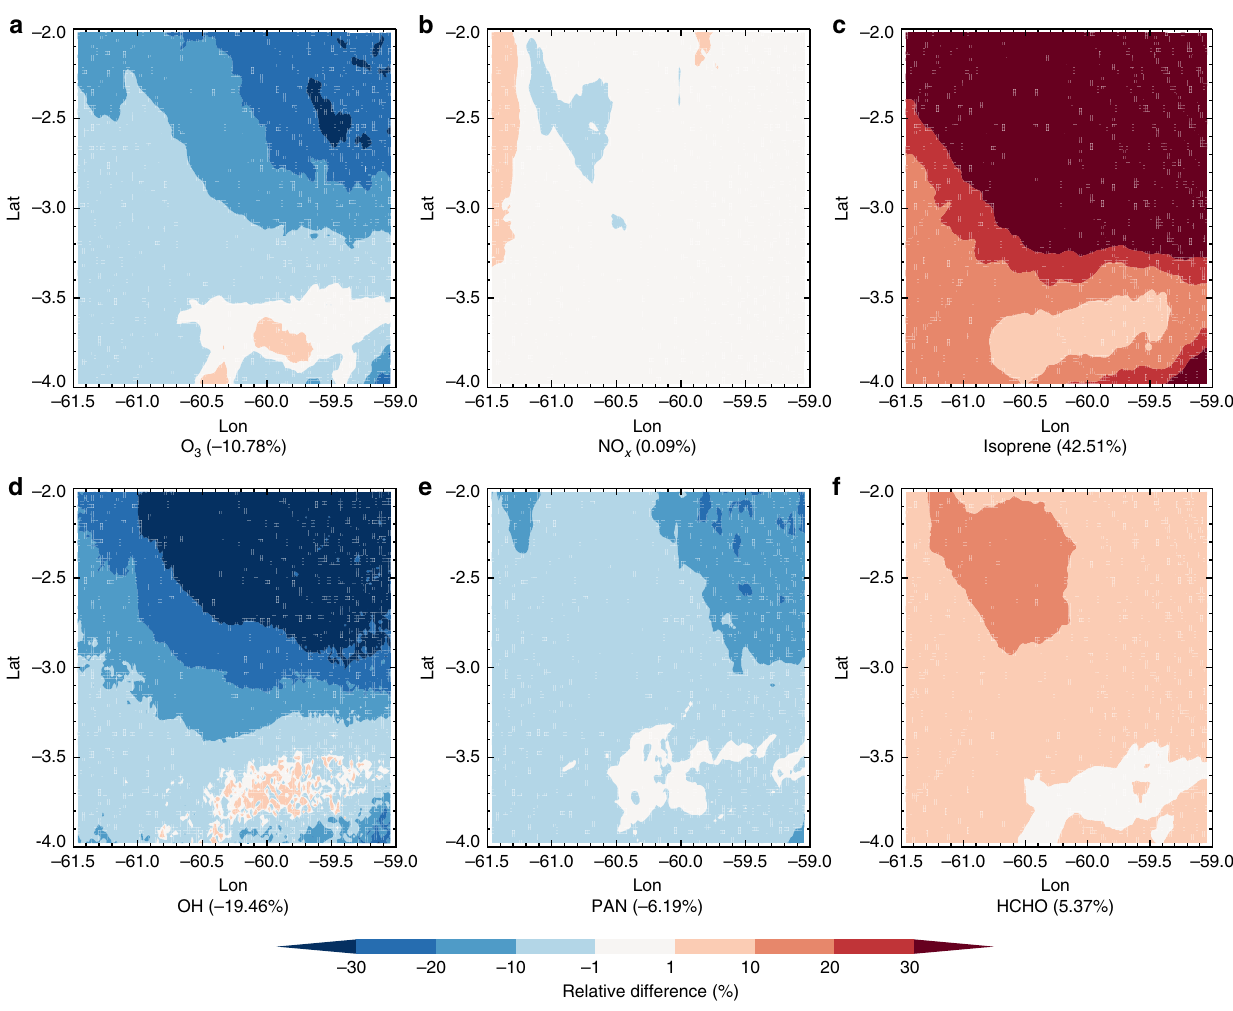
Figure 5 | Impact of revised isoprene EF. Relative changes of mixing ratios of O 3 ( a ), NO x ( b ), isoprene ( c ), OH ( d ), peroxyacyl nitrates (PAN) ( e ) and HCHO ( f ) in the boundary layer by updating the isoprene EFs simulated by WRF-Chem during September 2014; the mean value of the whole domain is reported in